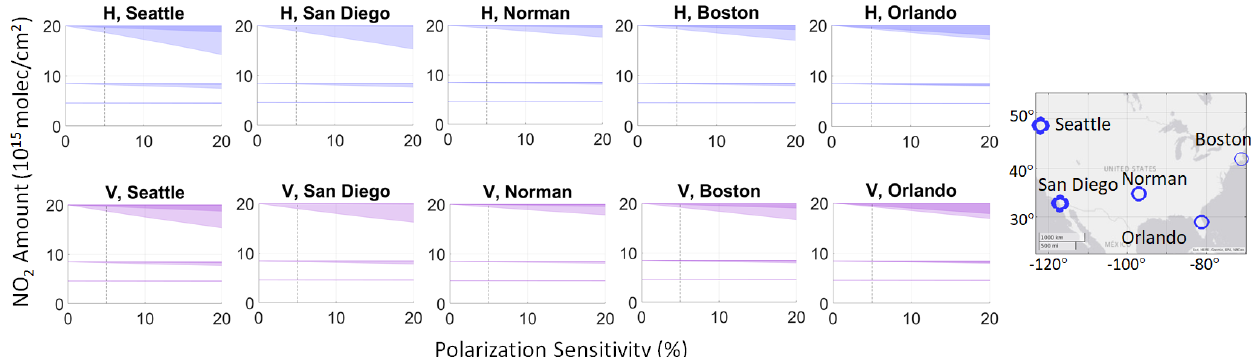
Figure 8. The retrieved amount is shown (left) as a function of polarization sensitivity (PS) for two different orientations (H – horizontal, V – vertical) for selected US locations and NO 2 total vertical amounts: 5.0, 8.6, and 20 × 10 15 molec.cm − 2 . The edge of the darker (lighter) shading shows the retrieved NO 2 amount with a solar zenith angle of 30 ◦ (70 ◦ ). The vertical dotted line shows the current PS requirement for reference. The locations are shown (right) on the map, with thicker circles representing higher NO 2 errors (see Table 3, Simulation C for more details.)